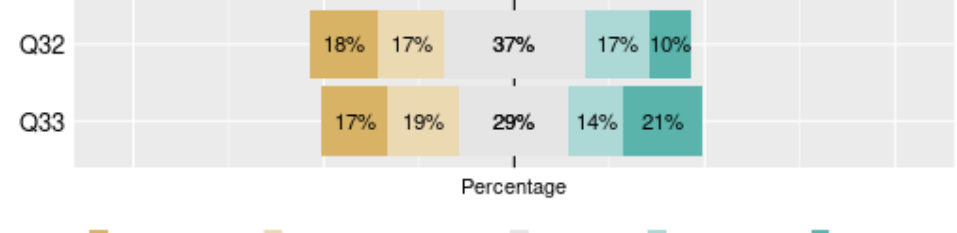
Figure 7. Results related to the dimension Adequacy of contracts and relations with